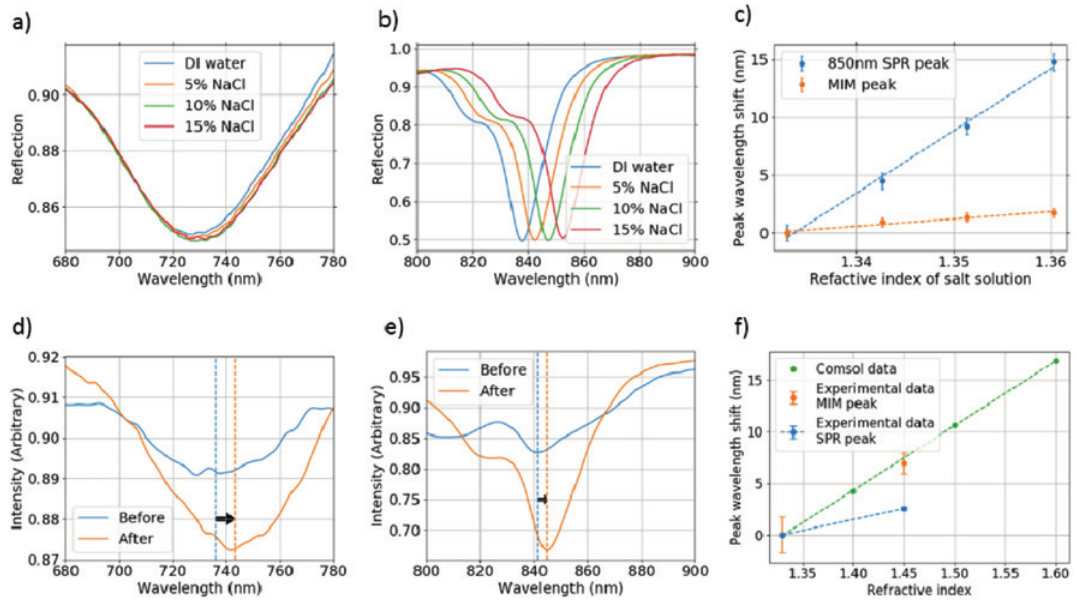
Figure 3: Sensitivity results comparing dips 2 and 3, i. e. the confined MIM and extended SPP mode, respectively. (a) MIM and (b) SPP bulk sensitivity spectra and (c) bulk peak wavelength shifts. (d) MIM and (e) SPP surface sensitivity spectra, before and after depositing 10 nm of